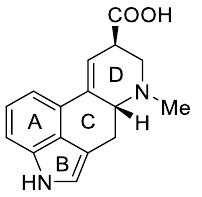
Figure 6. d -Lysergic